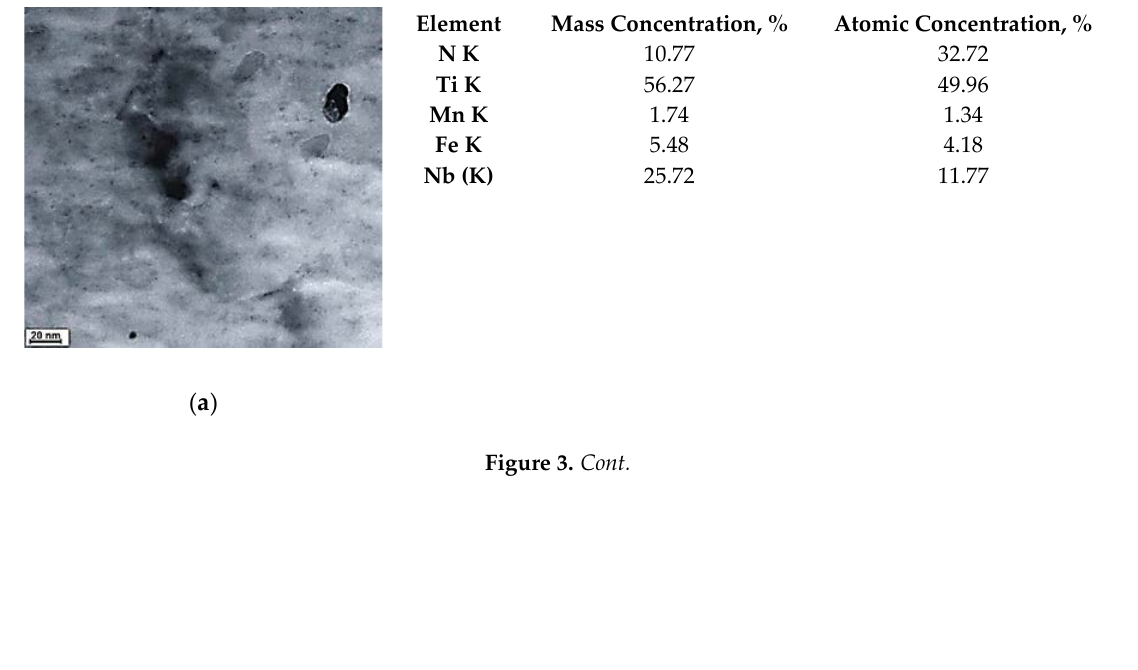
Figure 2. Microstructure of bainitic-ferritic steel S700MC with visible effects of plastic deformation. The tests of thin foils performed using a transmission electron microscope revealed that the hardening of steel S700MC was primarily caused by dispersive (Ti,Nb)(C,N)-type precipitates (a few nm in size) formed in the steel ferrite during cooling (Figure 3). The growth of recrystallised austenite grains in the steel was reduced by spherical (Nb,Ti)C and (Ti,Nb)(C,N) carbide precipitates having diameters of between 10 and 50 nm (Figure 4).